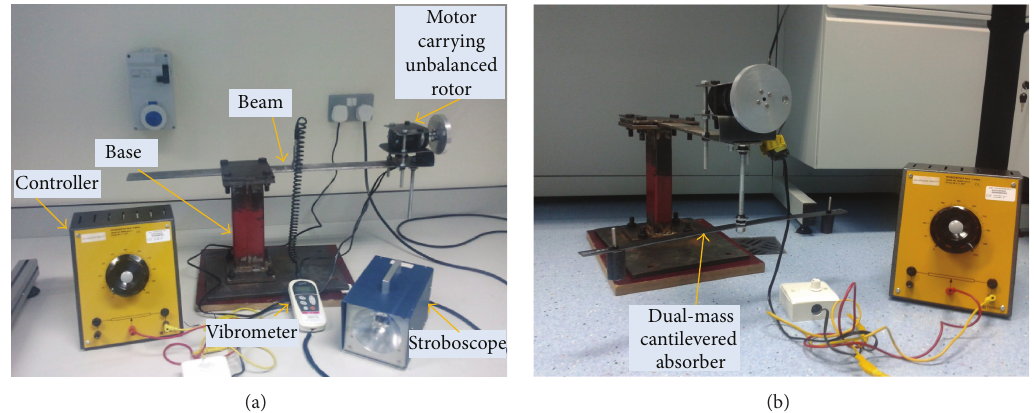
Figure 2: Photographs of the setup: (a) without absorber, (b) with the absorber.